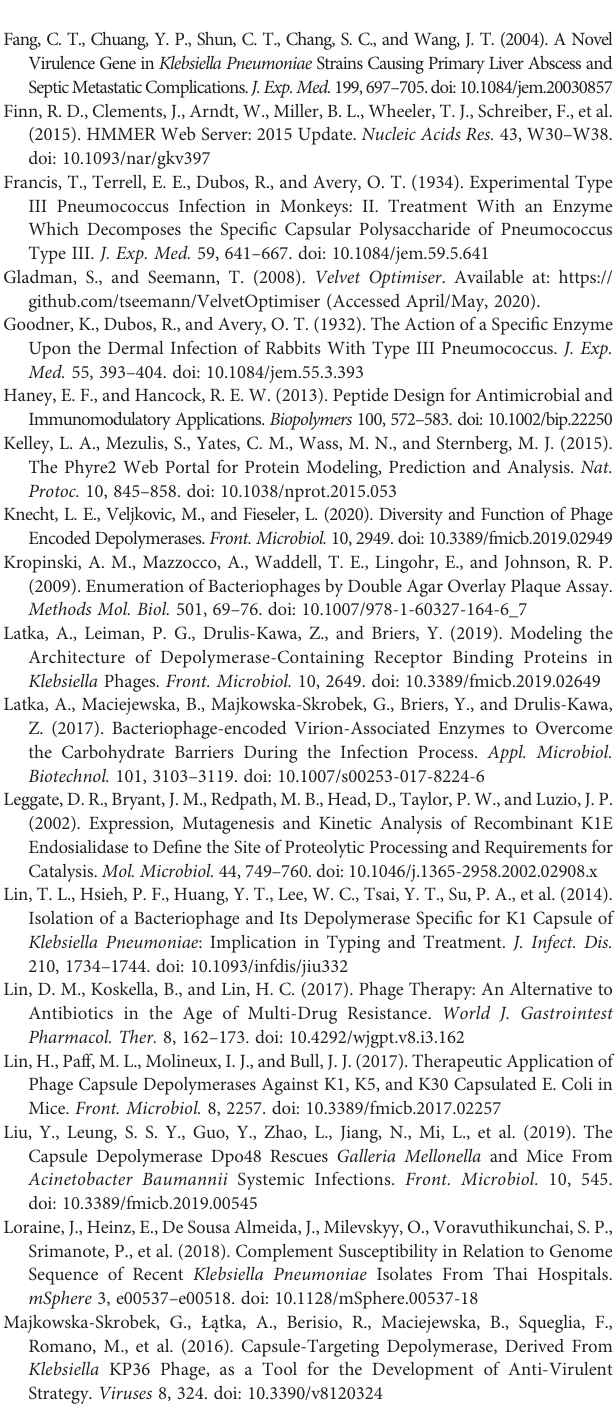
Supplementary Table 1 | Primersandconditionsforcloningofdepolymerasegenes. Supplementary Table 2 | Host range of 62 K . pneumoniae phage isolated from Thai sewage.